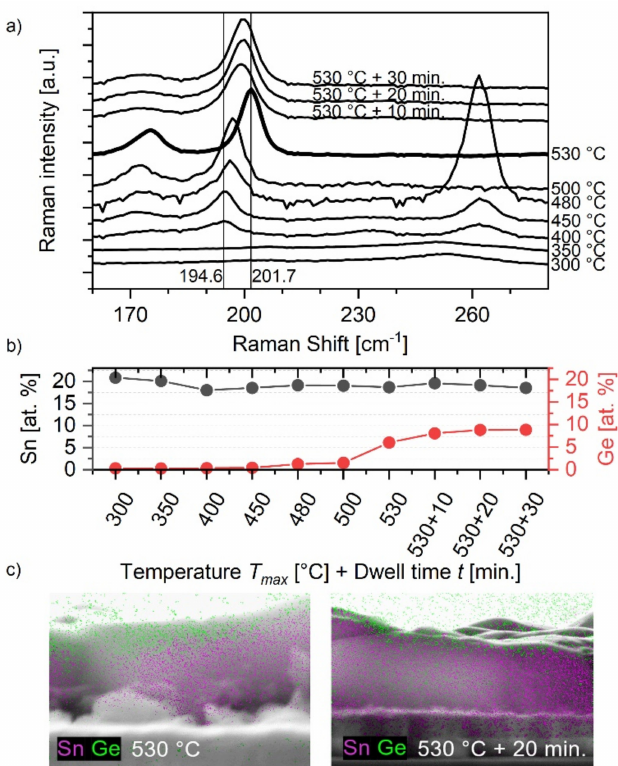
Figure 4. ( a ) Raman spectra and ( b ) atomic percentages of Sn and Ge for the samples prepared from interrupted-annealing experiments, quenched at temperatures of 300 ◦ C, 350 ◦ C, 400 ◦ C, 450 ◦ C, 480 ◦ C, 500 ◦ C, 530 ◦ C and for samples with T max of 530 ◦ C including a dwelling step of 10 min, 20 min and 30 min duration. ( c ) The cross-section EDX mappings show the distribution of Sn and Ge for samples without and with a dwelling